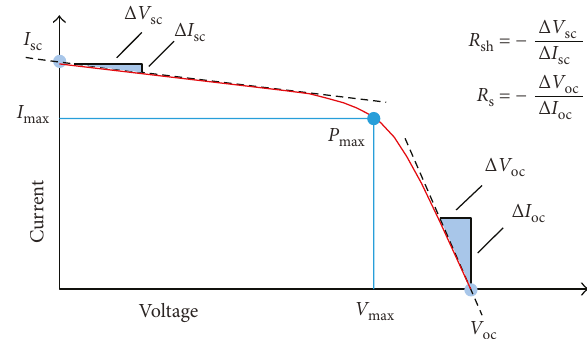
Figure 2: Series and shunt resistance extraction from a single I-V curve under